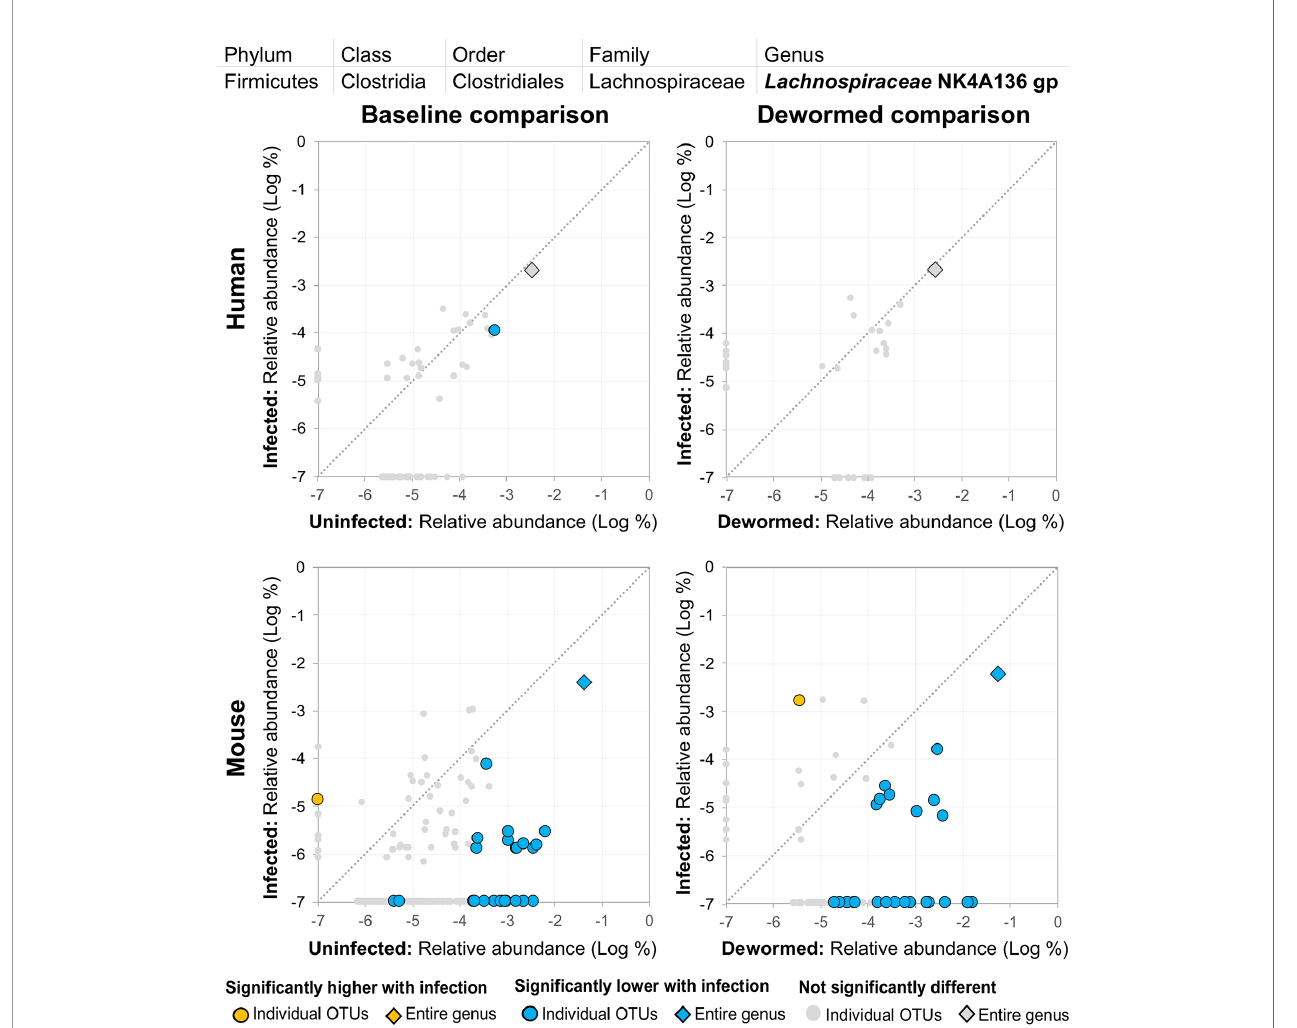
FIGURE 12 | The relative abundance (%) of all Lachnospiraceae NK4A136 group (genus) OTUs in each differential comparison among samples from whipworm- infected and uninfected humans and mice. Signi fi cant differentially abundant OTUs in each comparison (as identi fi ed by LEfSe) are colored in orange (higher with infection) and blue (lower with infection). The sum of all OTUs in the genus is represented with a diamond symbol. This is one of three genera with at least one OTU signi fi cantly lower in infection in three of four